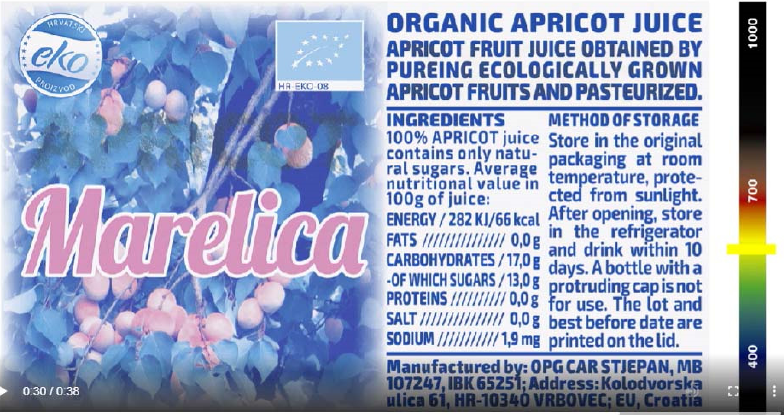
Figure 7. Animation of a specimen stopped with blockade at 600 nm: https://jana.ziljak.hr/apricot.mp4 (accessed on 14 October 2022).